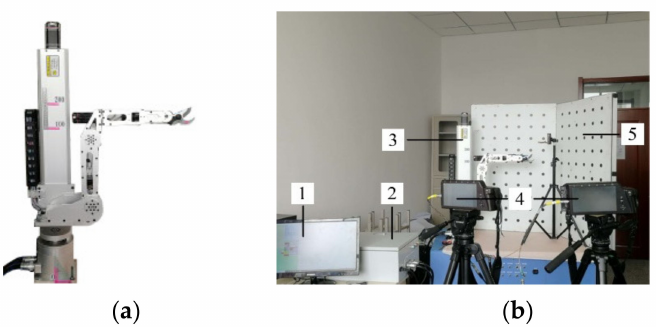
Figure 11. The platform for the manipulator performance test. ( a ) Prototype and ( b ) test platform. 1. PC machine; 2. Control box; 3. Manipulator; 4. 3D high-speed camera; and 5. Calibration